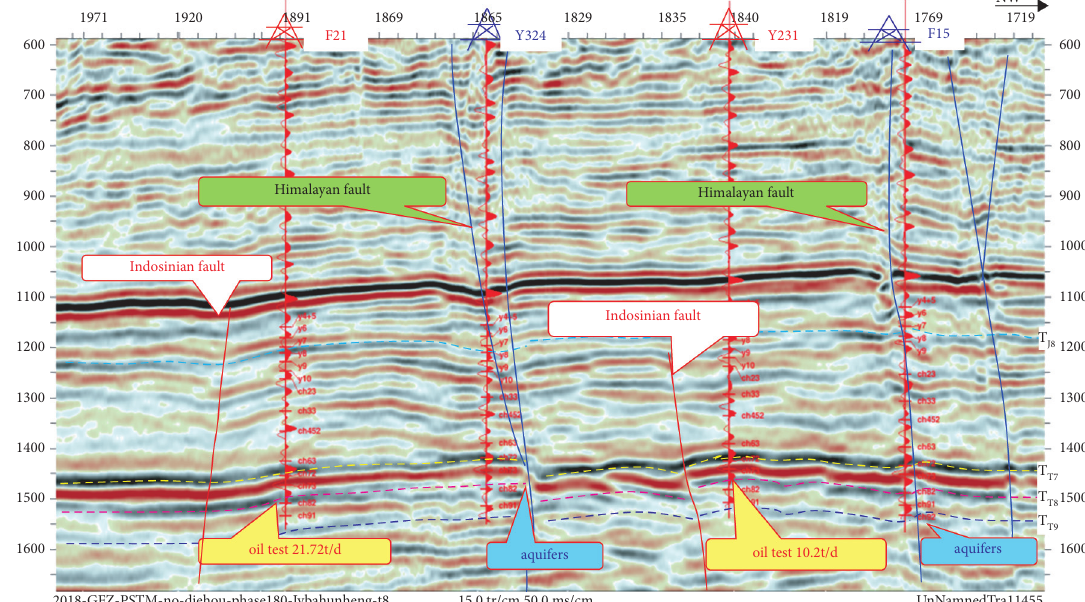
Figure 9: Seismic profile from well Feng21 to well Yan231 in the Yanchi area (the profile position is shown in Figure